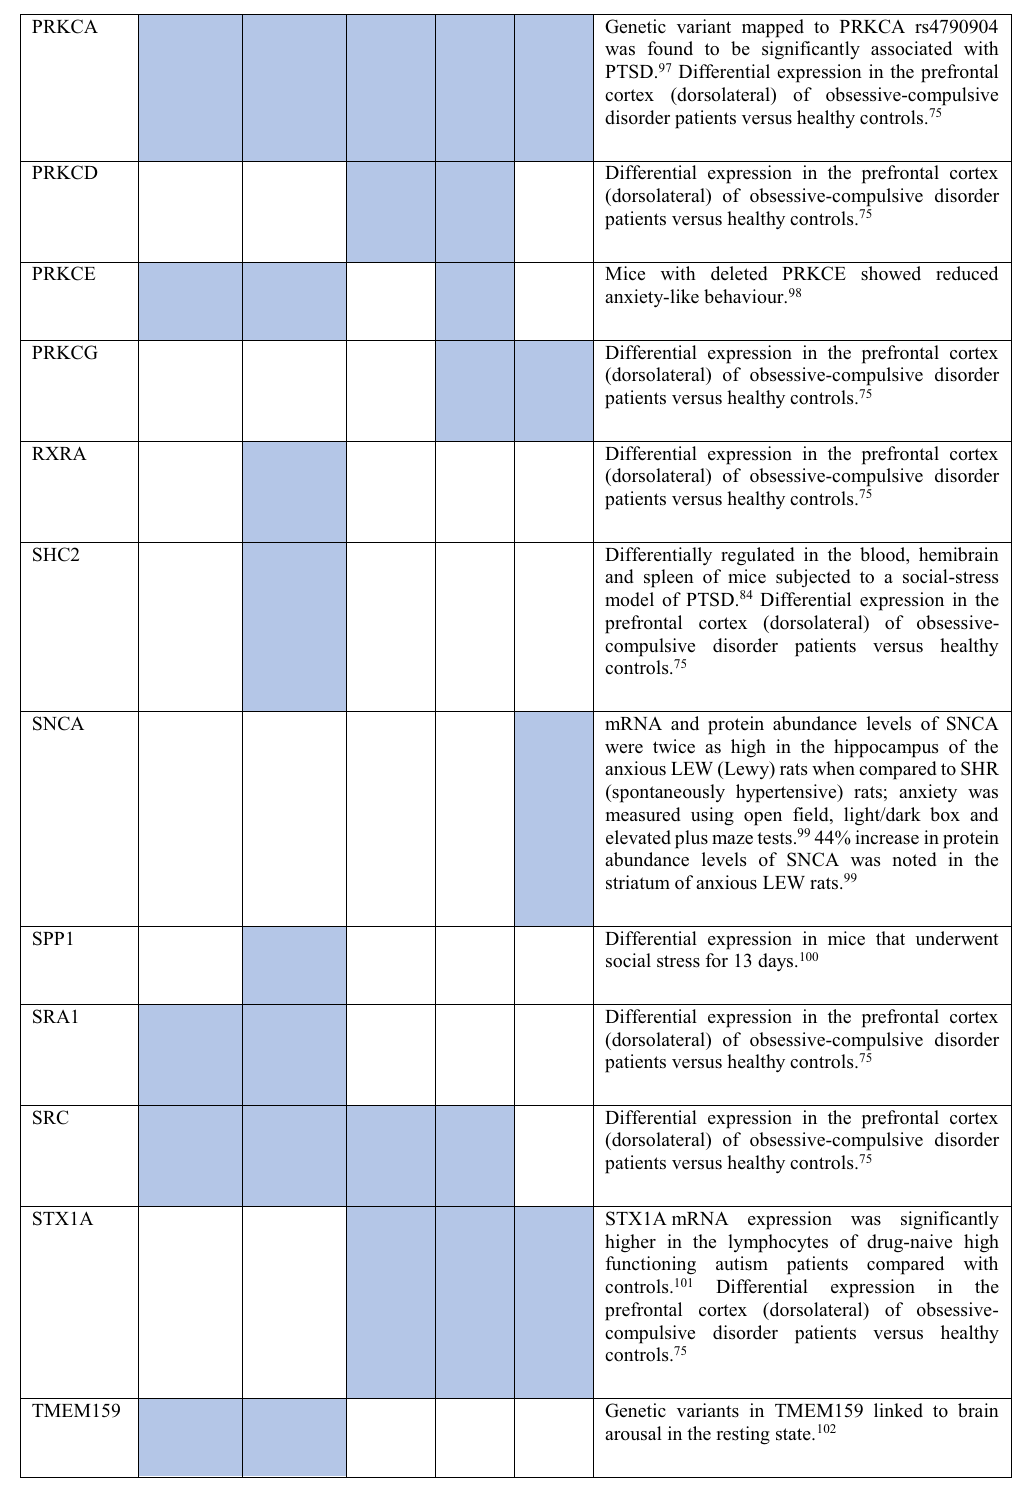
Table 2. Genes present in AD-SMIs that were expressed in the four key brain regions influential in producing the grouping pattern of ADs (shown in Fig. 4a,c). A colored cell indicates the presence of the particular gene in the corresponding AD-SMI. The final column presents the literature evidence supporting the potential role of the given genes in anxiety